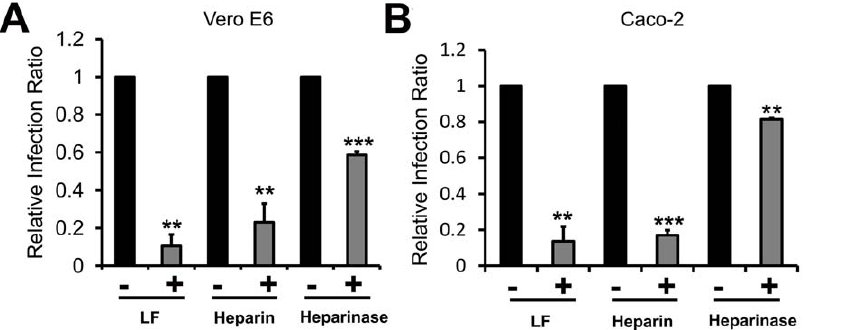
Figure 7. LF, heparin or enzymatic removal of cell surface HSPGs can prevent SARS pseudovirus entry into Vero E6 or Caco-2 cells. ( A ) Interference of the interaction between Vero E6 and SARS pseudovirus by LF, heparin and heparinase leads to reduction of viral infection. Vero E6 cells were treated by the same methods above with 10 m M LF, 10 m M heparin or 10 U of heparinase I, respectively. Then, the cells were incubated with SARS pseudovirus as described in Methods. GFP-expressing cells in the total population were analyzed by flow cytometry. The relative viral infection ratio was measured by comparing the percentage of GFP expressing cells of each group to that of the control. Error bars represent the SD of three independent experiments. *** P , 0.001 and **P , 0.01. ( B ) Incubation with LF or heparin, or degradation of HSPGs by heparinase inhibits SARS pseudovirus infection of Caco-2 cells. The Caco-2 cells were treated by same methods as described above. *** P , 0.001, **P , 0.01 and *P , 0.05.